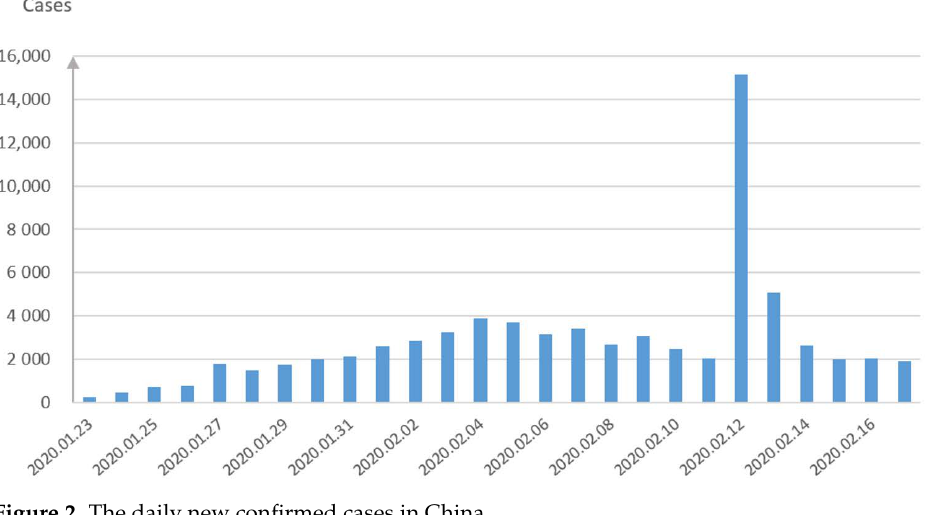
Figure 2. The daily new confirmed cases in China.